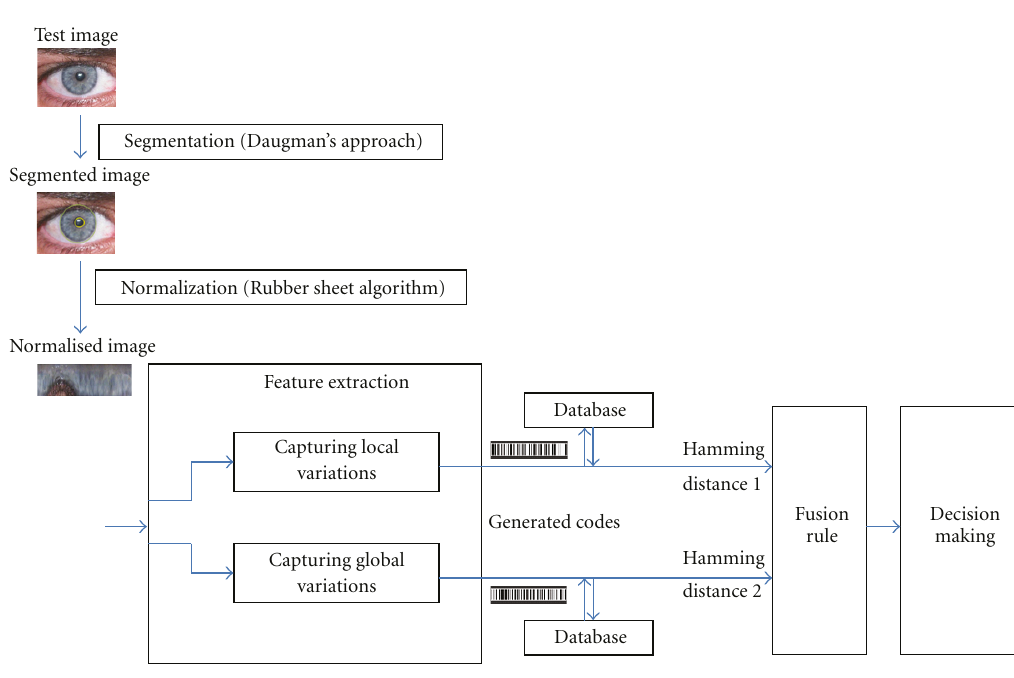
Figure 2: An algorithmic overview of the proposed recognition method.